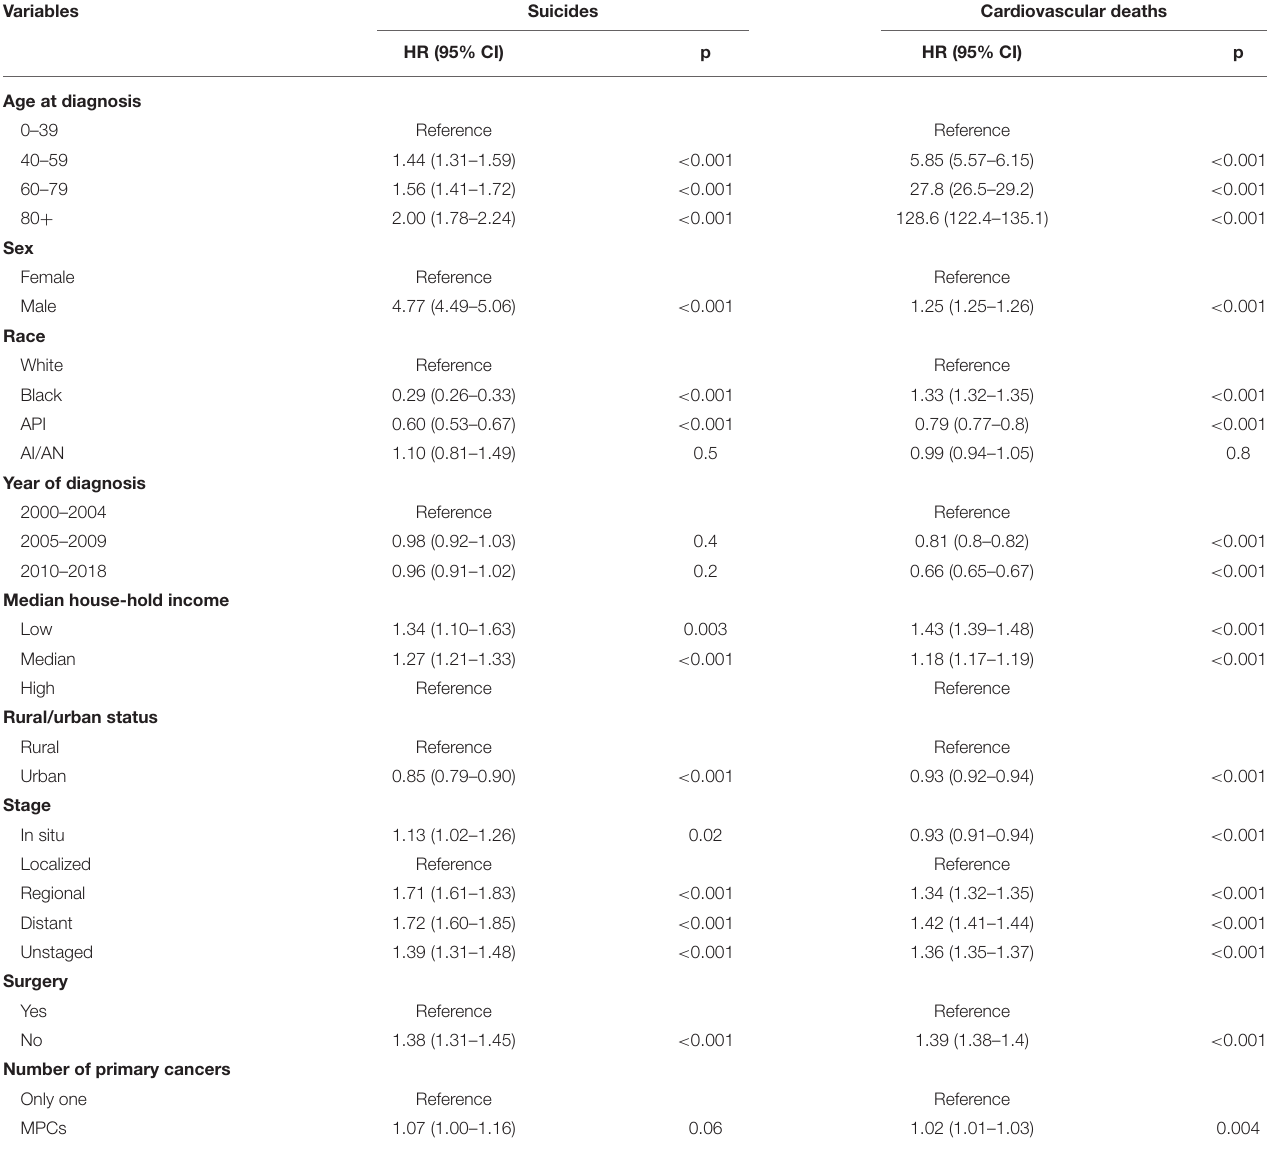
TABLE 2 | Multivariable Cox analysis to compare the cumulative mortality rate of suicide and cardiovascular deaths among patients with multiple primary cancers to those with only one primary